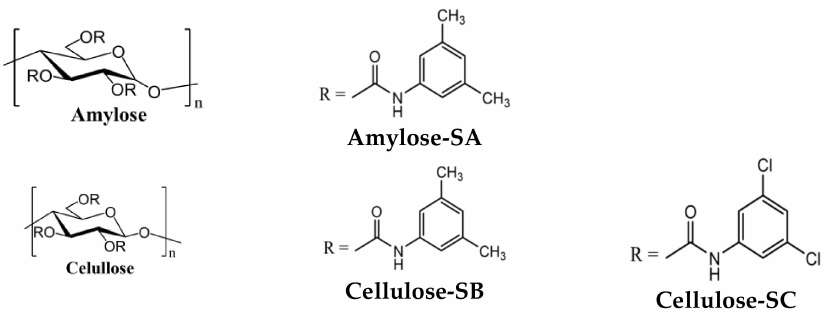
Figure 4. Chemical structures of chiral